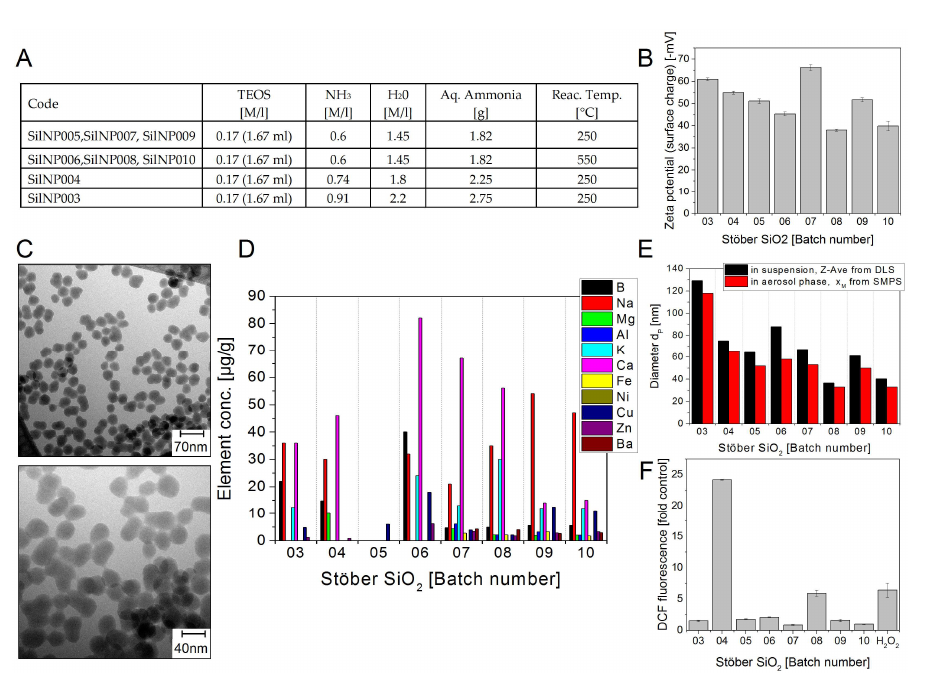
Figure 1. Stöber synthesized silica SilNP03–10 ( A ) Production parameters for the different Stöber synthesized silica nanoparticles. ( B ) Zeta potential representing the surface charge in –mV at pH 8.4 ± 0.57. ( C ) Representative transmission electron microscopy (TEM) images ( D ) Selected impurities present in the different Stöber synthesized SiO 2 NM batches. The mass concentrations of elements above detection limit are shown. The data represent the mean of two assays. ( E ) Particle diameters d P in nm: Z-Average of d P determined in aqueous suspension using dynamic light scattering (DLS) (black bars) and modal value x M of the number size distribution in the aerosol phase measured by mobility spectrometry (SMPS) (red bars). ( F ) Potential to induce ROS. The test NMs were delivered as suspensions of 5 mg/mL in water. The graph shows the Dichlorofluorescein (DCF) fluorescence induced by the different batches at 400 µg/mL relative to a sample without NMs (control). 0.3 µM H 2 O 2 was used as a positive control. Additional tested was the commercial material SilNP02. The data represent mean values of two independent experiments with three replicates ± s.e.m.